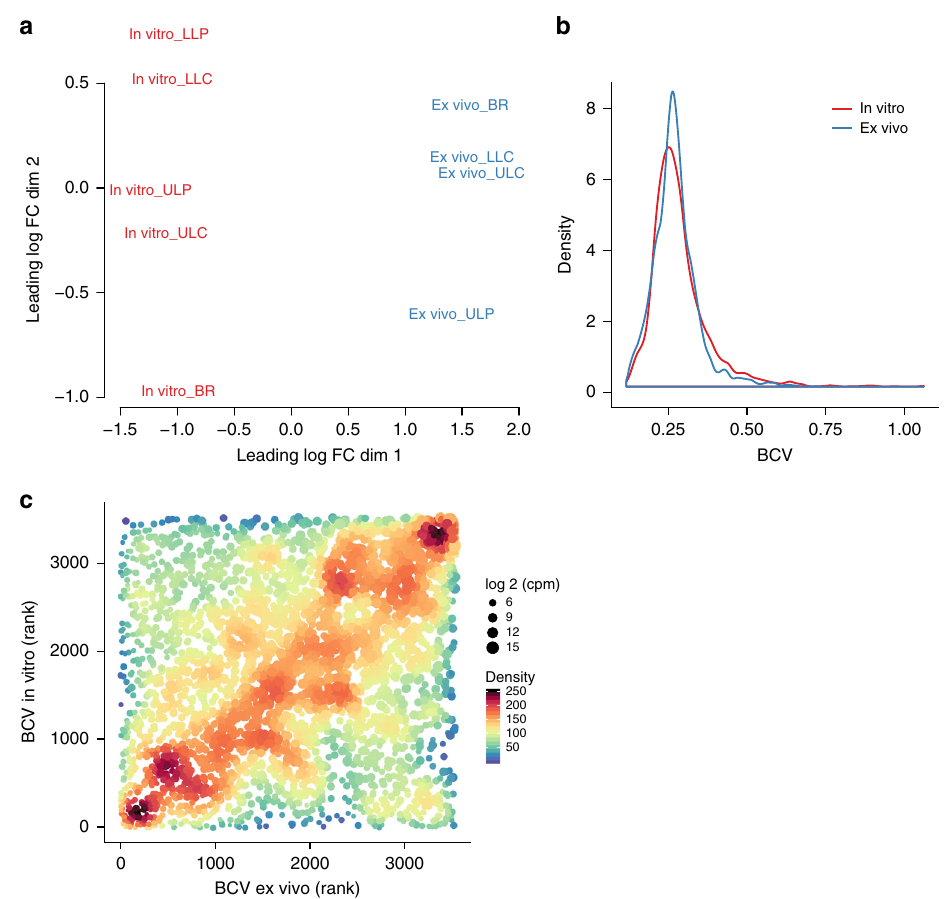
Fig. 5 Variances of gene expression in vitro and ex vivo. To reduce the in fl uence of sequencing depth on variance, sample reads were subsampled to the same level and fi ltered (counts per million (cpm) in all samples ≥ 5). Distribution of normalized reads was comparable in all samples after data